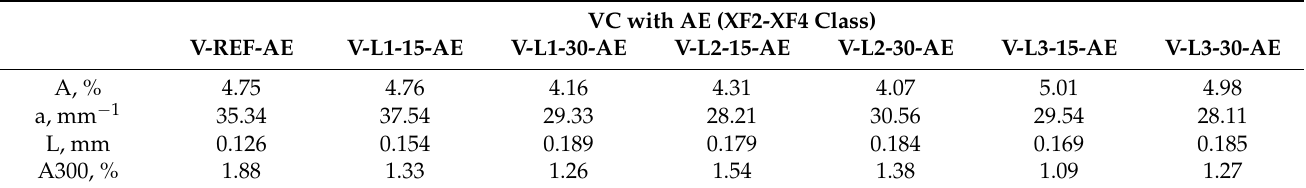
Table 6. Air void distribution parameters for vibrated air-entrained concrete.